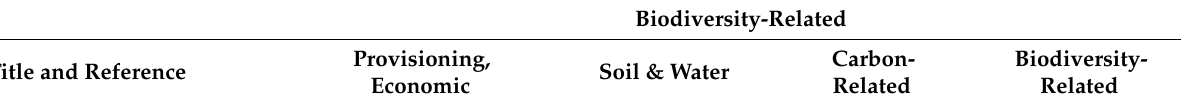
Table 1. Papers quantifying change in ecosystem services related to farmer/manager